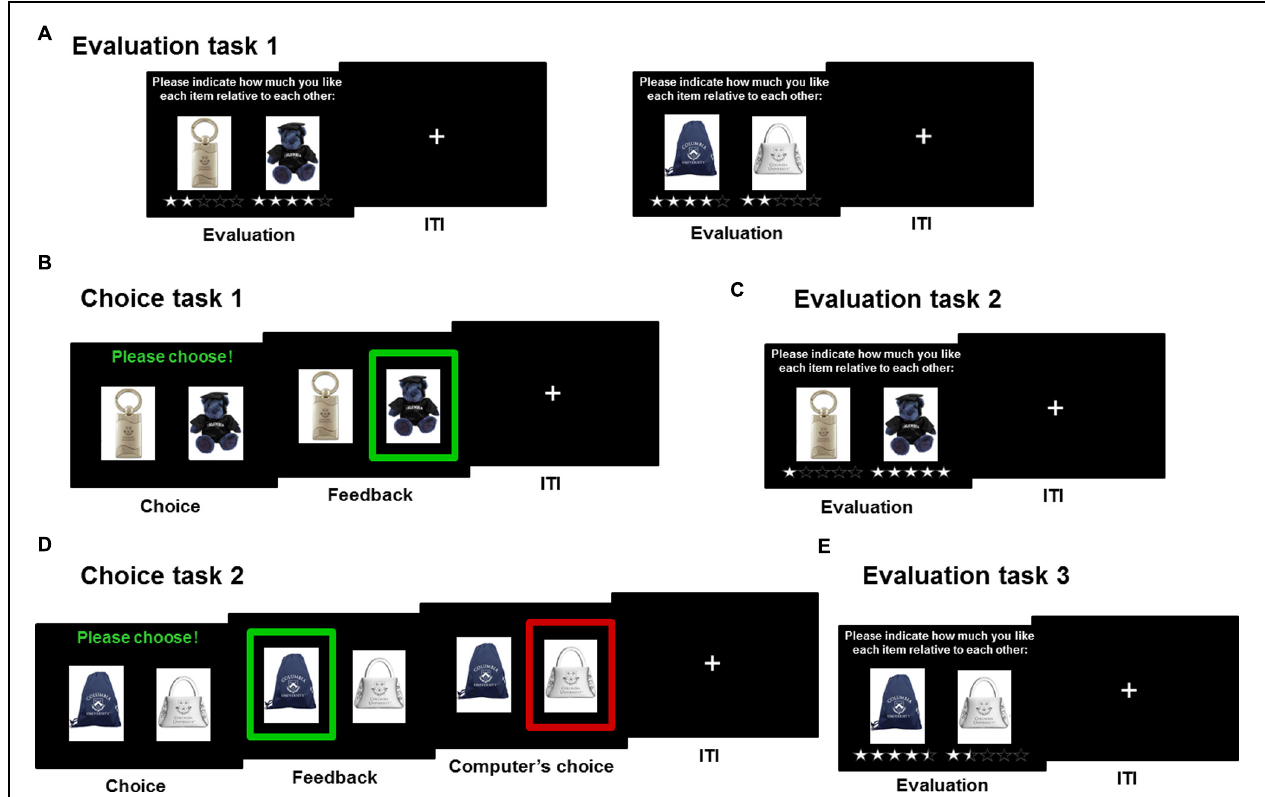
FIGURE 1 | Experimental design illustration. (A) Participants first evaluated objects relative to one another. (B) In Choice task 1, they were asked to choose the object they liked most. (C) Subsequently, they evaluated again the pairs of objects presented during Choice task 1. (D) In Choice task 2, participants made choices again between two objects but one of the two objects was then selected by the computer. (E) Finally, participants evaluated the pairs of objects presented during Choice task